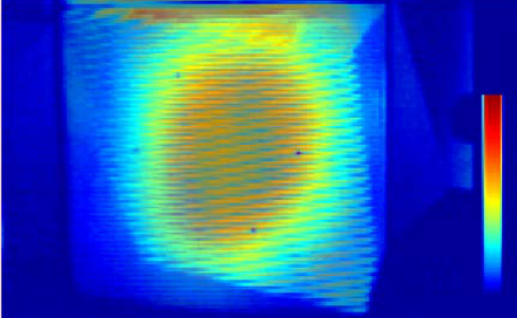
Fig. 2: Infrared footprint of a ECRH beam at the O2-reflector tile with holographic grating at its